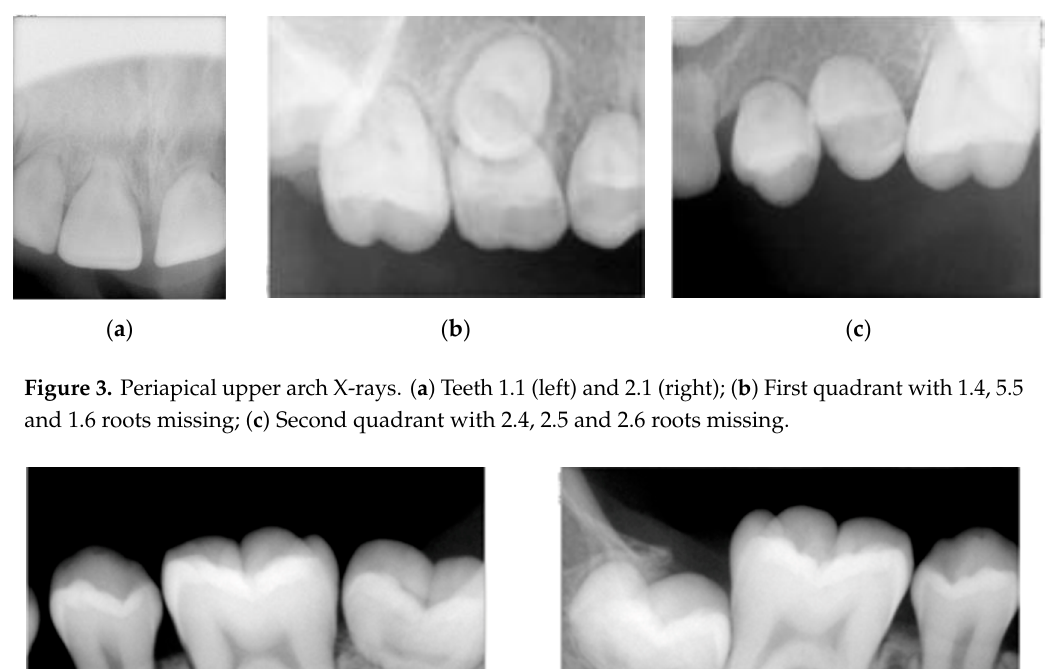
Figure 2. Panoramic x-ray.